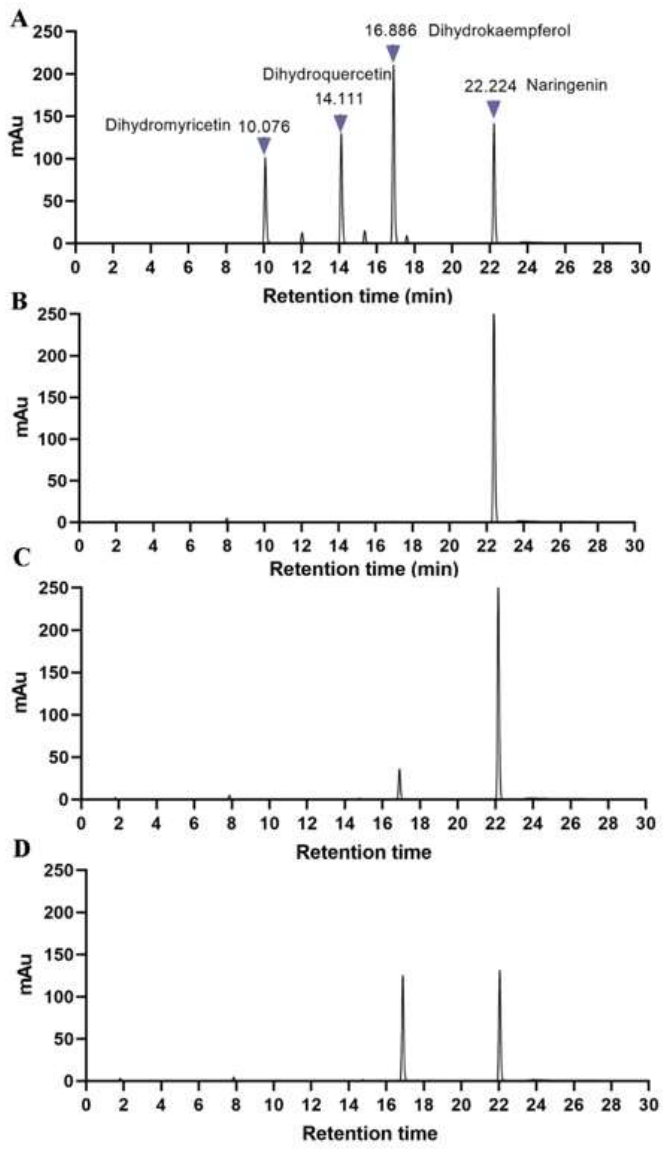
Figure 2. Enzymatic assay of MazsF3H in vitro using HPLC-VWD: ( A ) Chromatogram of standards. ( B ) Reaction containing boiled MazsF3H as control. ( C ) Reaction containing 10 μg MazsF3H proteins. ( D ) Reaction containing 20 μg MazsF3H proteins.